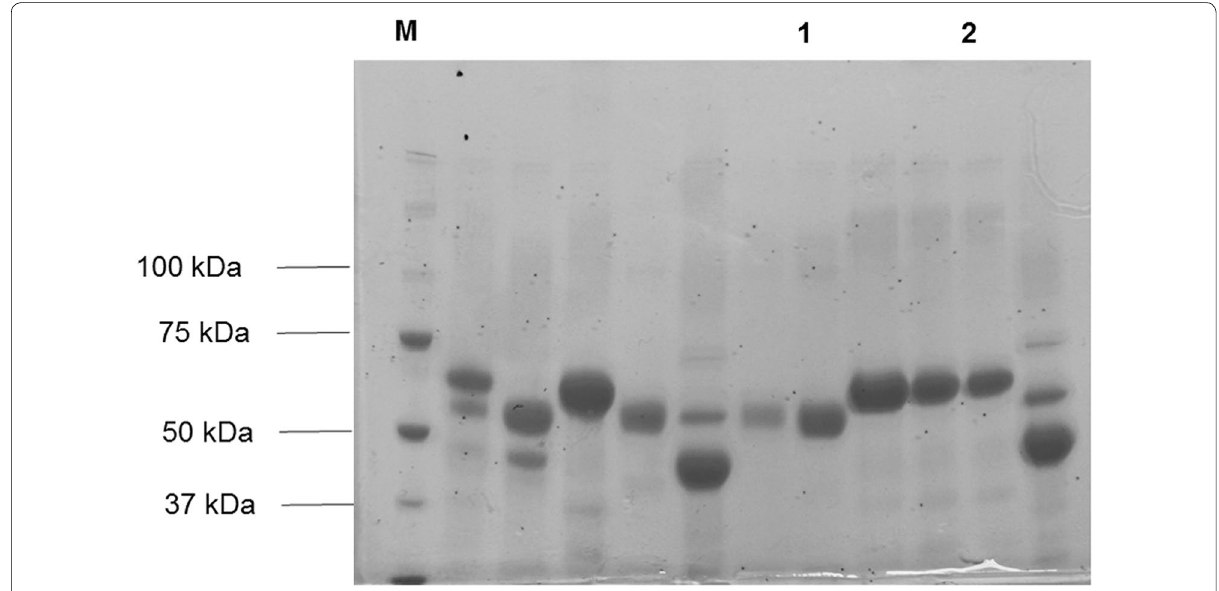
Fig. 5 SDS-polyacrylamide gel electrophoresis of the purified cellulase enzymes. M molecular mass marker, (1) CBH II (2) CBH